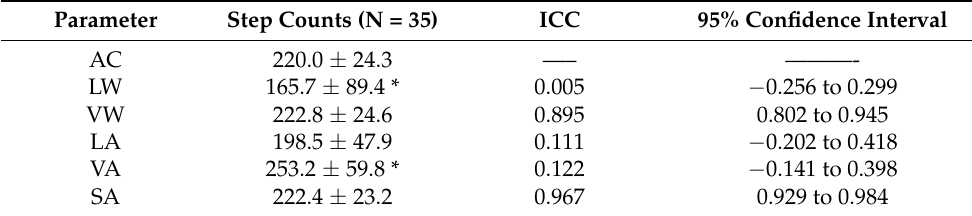
Table 4. Activity monitor step counts.